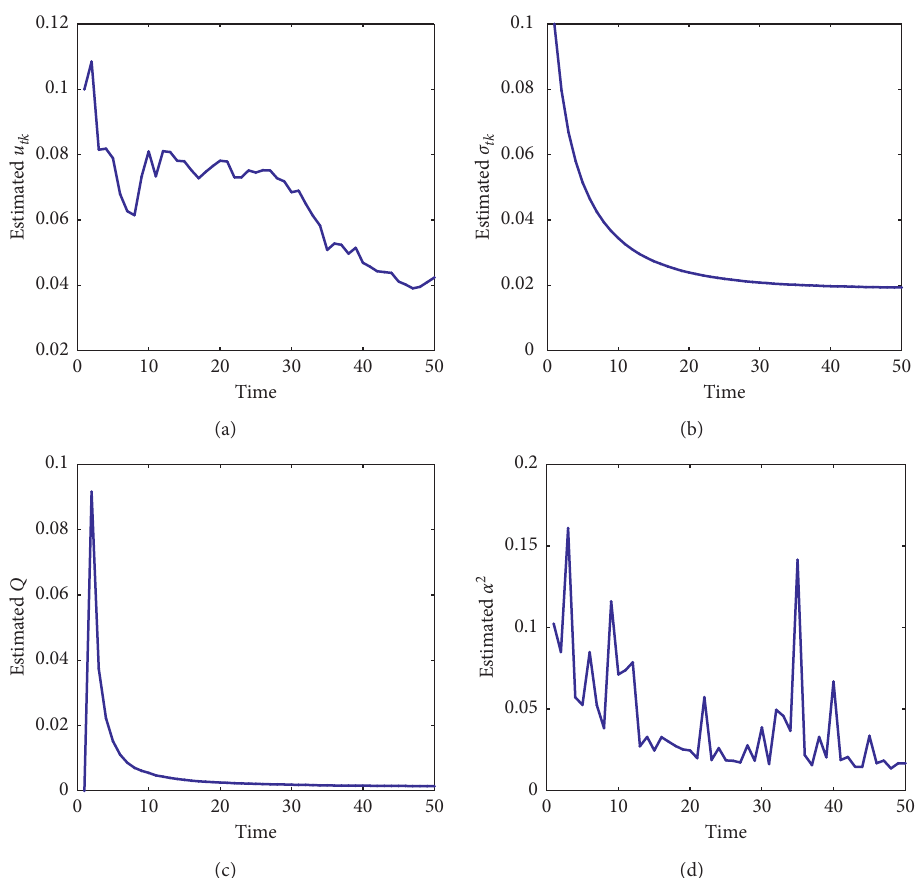
Figure 2: The estimated parameters for system (2) with initial conditions given in Example 1.